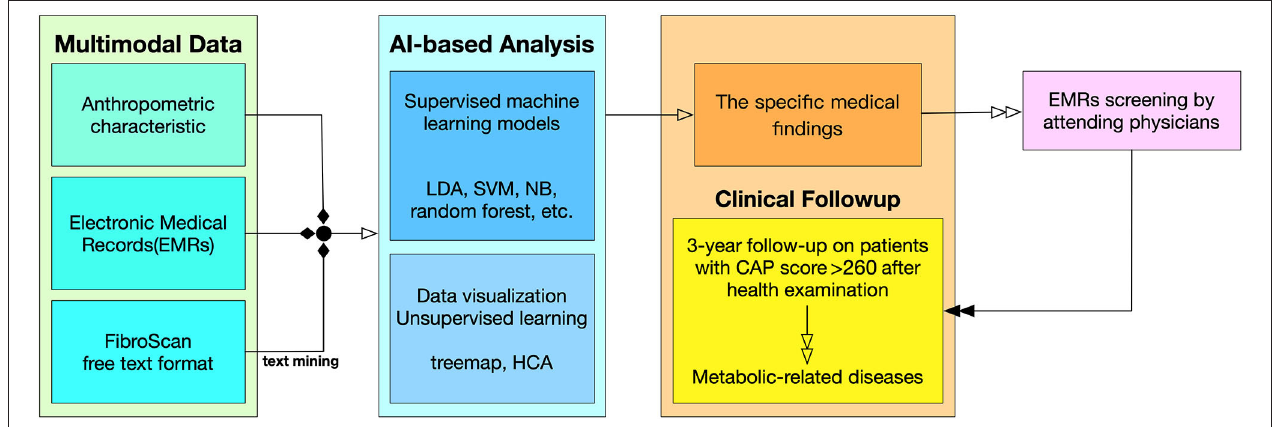
FIGURE 1 | Flowchart from data collection to clinical follow-up. Multimodal Data. The input variables are divided into three types of sources in the clinical data collection. The detail list of inputs can be found in Supplementary Table 3 . AI-Based Analysis. This study used both supervised machine learning model and unsupervised machine learning along with data visualization techniques. Clinical Follow-up. The result of the AI-based analysis feedback to physicians, and the physicians investigate the outcome of the patients through EMRs screening.